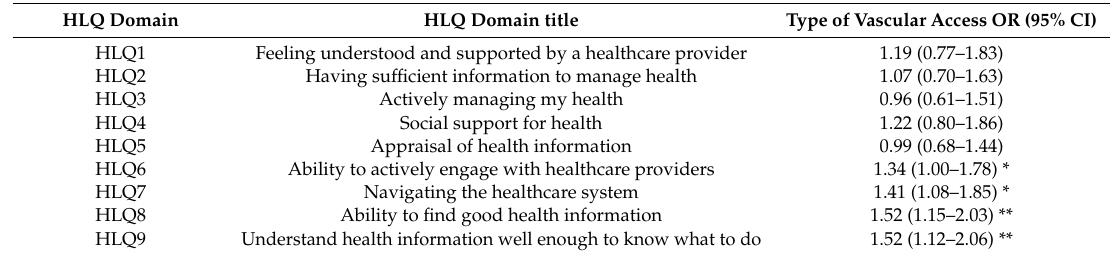
Table 2. The associations between health literacy domains and the type of vascular access. Logistic regression model adjusted for age, gender, education, CCI, and diabetes mellitus ( n =